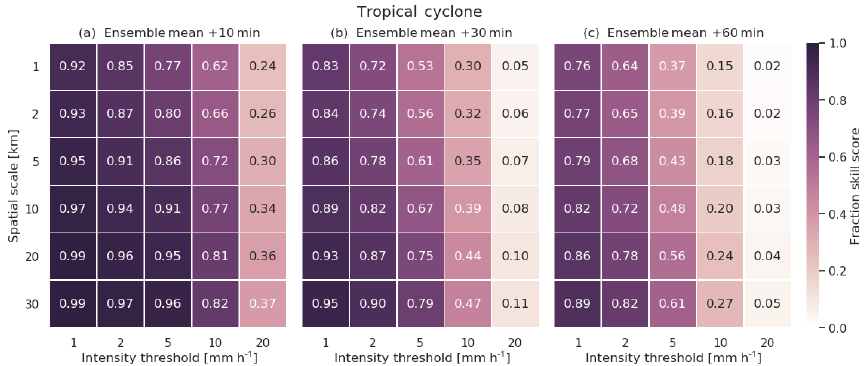
Figure 22. Comparison of fractions skill score (FSS) values for (a) + 10min, (b) + 30min and (c) + 60min nowcasts rainfall ensembles for tropical cyclone Penny (event no. 1 in Table 10). FSS values were calculated comparing the ensemble mean for each lead time with observations.